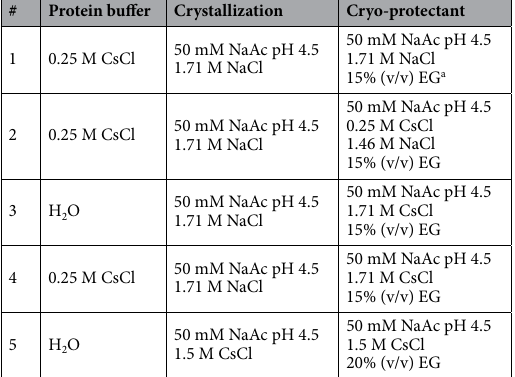
Table 1. Crystallization and cryo-protectant conditions of HEWL crystals. a Ethylene glycol.